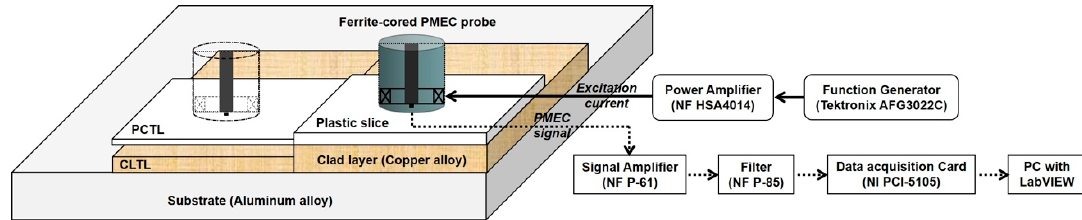
Figure 7. Schematic illustration of the PMEC system.